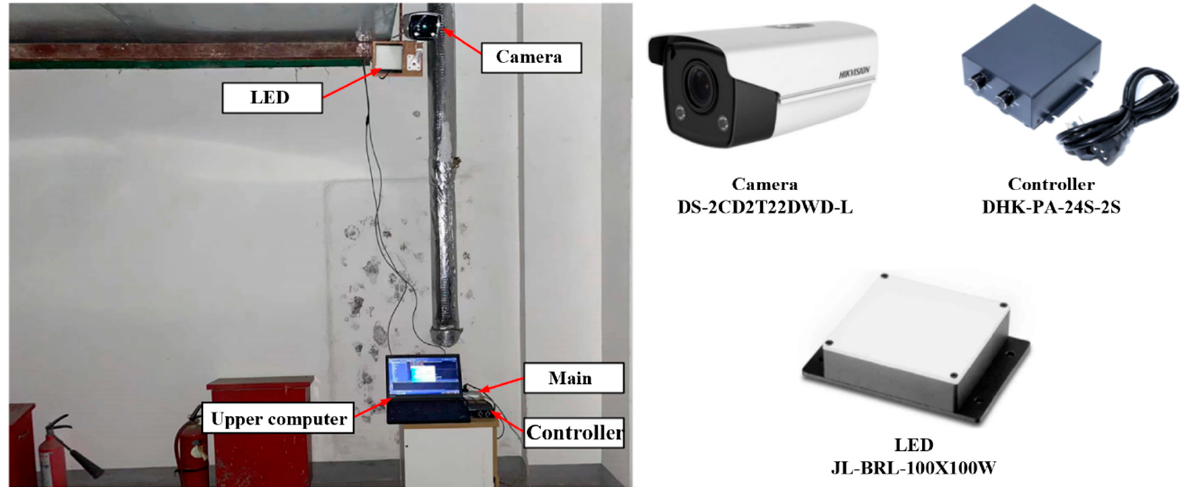
Figure 16. Experimental facilities.